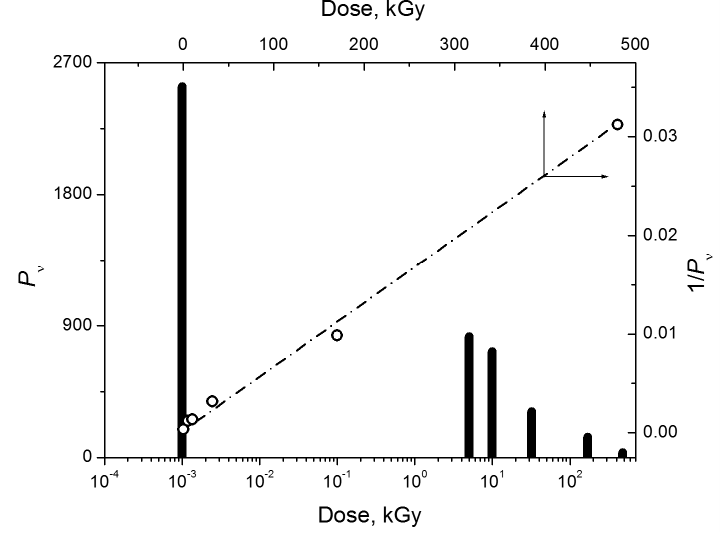
Figure 2. Dose effect on degree of polymerization of cotton cellulose